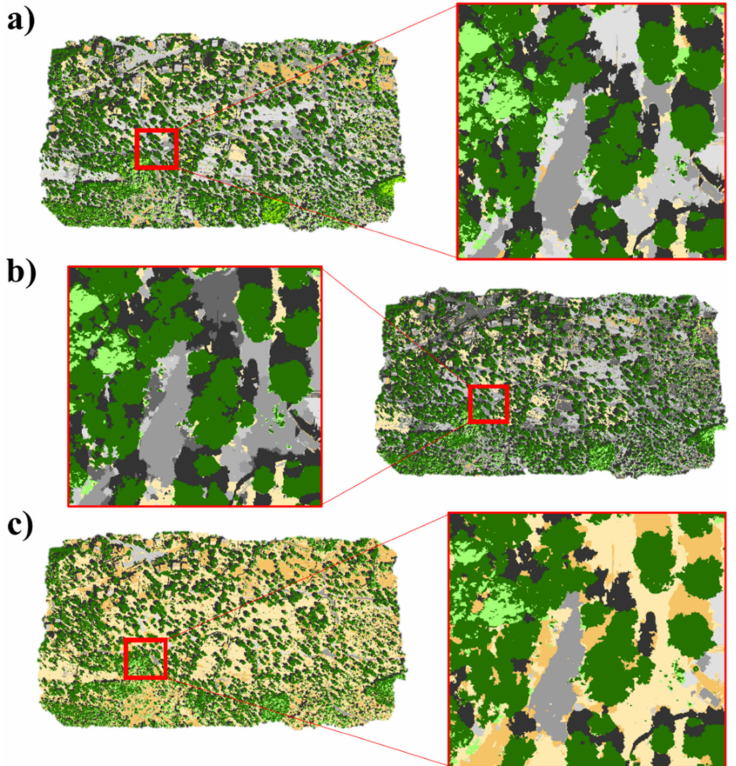
Figure 11. Classified models: ( a ) SVM; ( b ) MLC; ( c ) RTC.